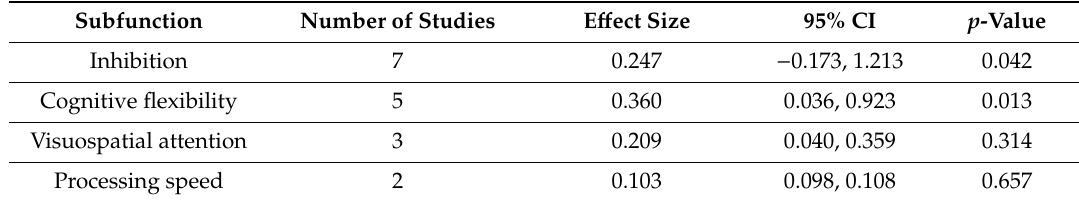
Table 3. Conditions of specific performance.